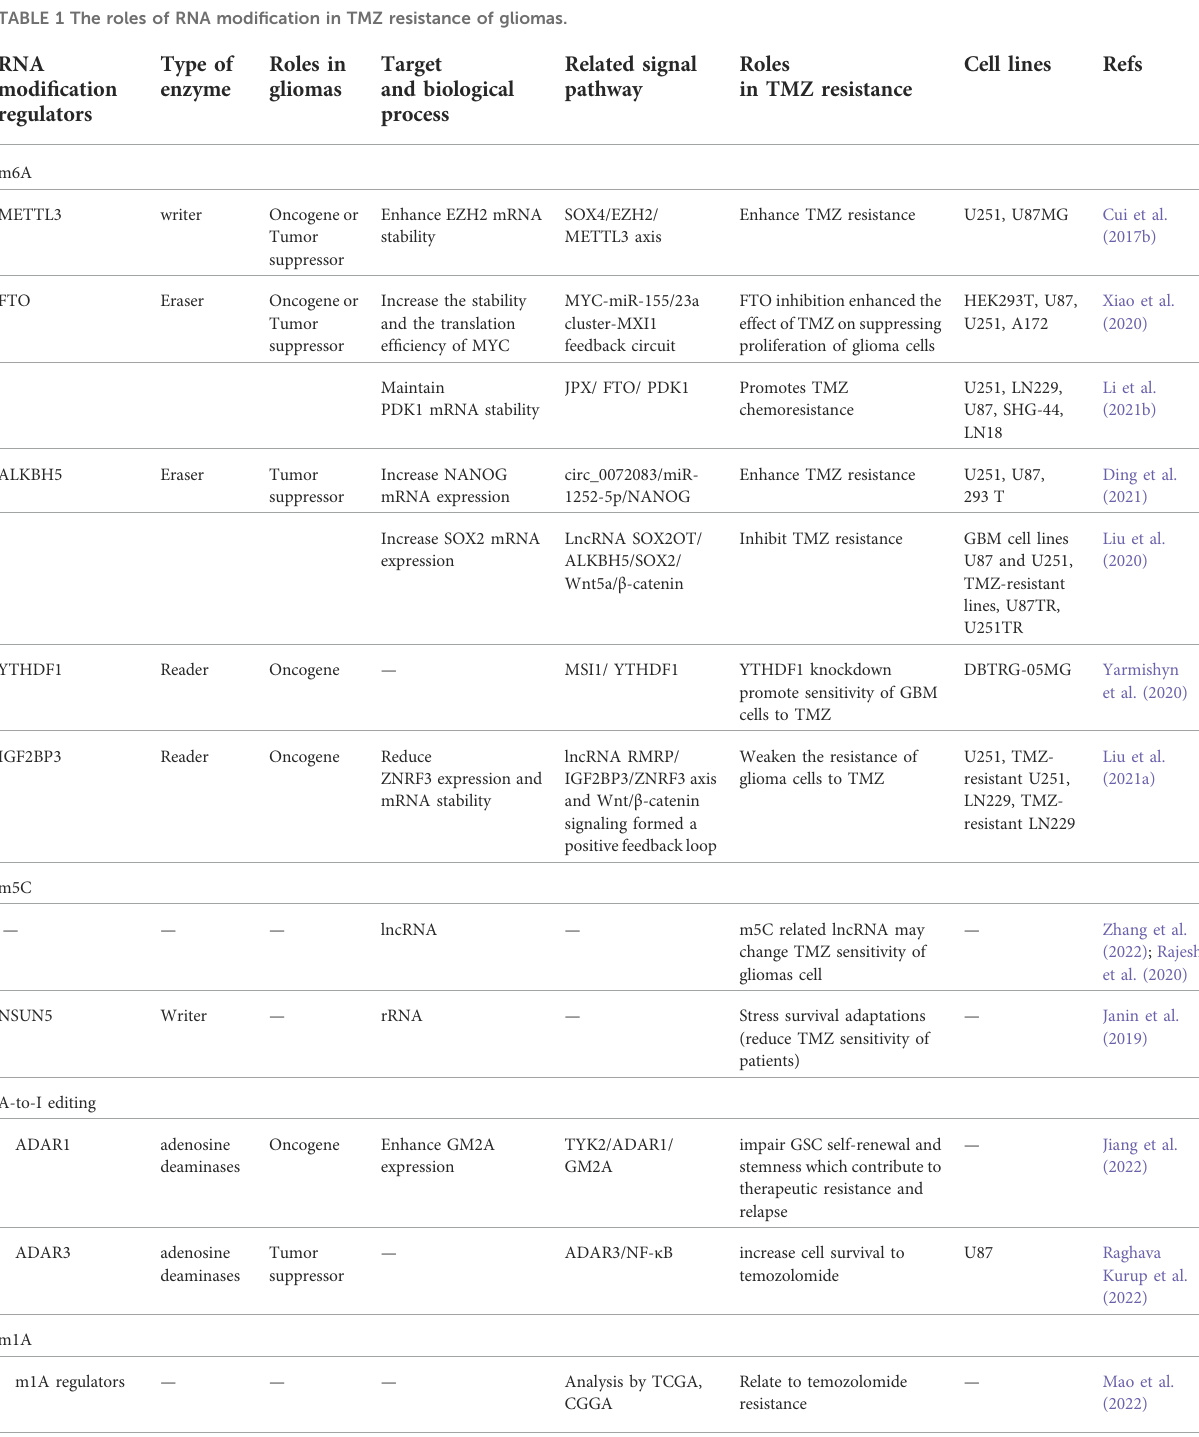
TABLE 1 The roles of RNA modi fi cation in TMZ resistance of gliomas. RNA modi fi